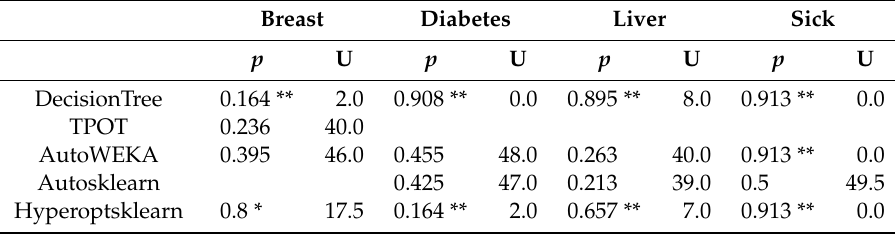
Table 2. P -values and U statistic for Mann–Whitney U test compared to best performer. Breast Diabetes Liver Sick p U p U p U p U DecisionTree 0.164 ** 2.0 0.908 ** 0.0 0.895 ** 8.0 0.913 ** 0.0 TPOT 0.236 40.0 AutoWEKA 0.395 46.0 0.455 48.0 0.263 40.0 0.913 ** 0.0 Autosklearn 0.425 47.0 0.213 39.0 0.5 49.5 Hyperoptsklearn 0.8 * 17.5 0.164 ** 2.0 0.657 ** 7.0 0.913 ** 0.0 * p < 0.01 ** p <